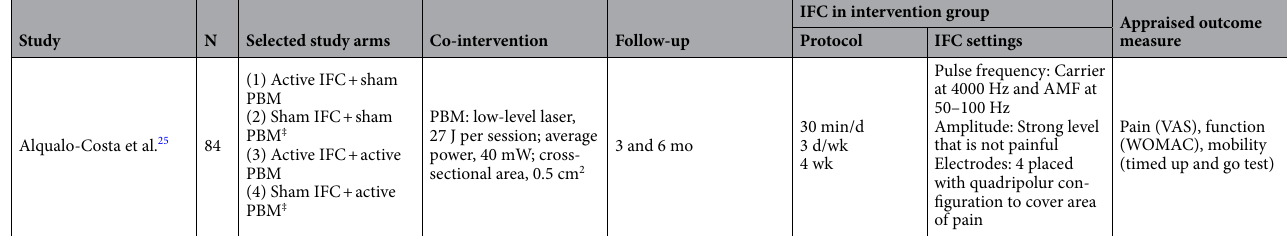
Table 1. Summary of the characteristics of the included studies. N number of patients, IFC interferential current therapy, d day, wk week, mo month, min minute, Hz hertz, N/A not applicable, VAS visual analog scale, ROM range of motion, AMF amplitude-modulated frequency, WOMAC Western Ontario and McMaster Universities Osteoarthritis Index, PBM Photobiomodulation. † IFC versus Placebo/Sham. ‡ IFC + Other therapy versus other therapy.